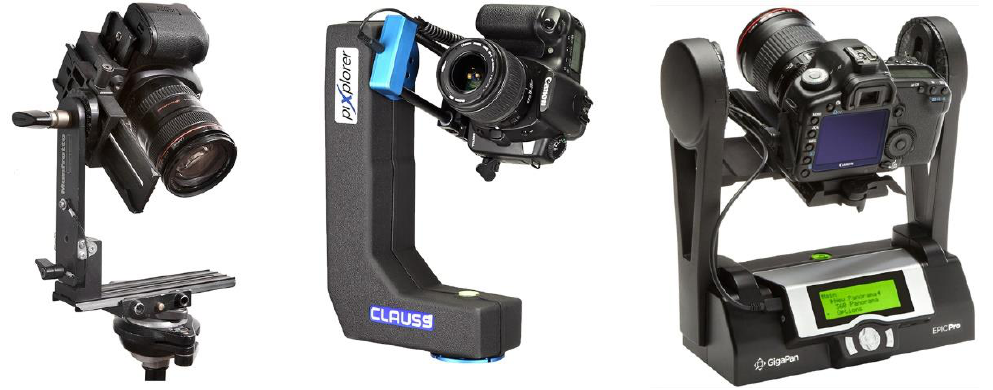
Figure 2. Manual and motorized panoramic heads.